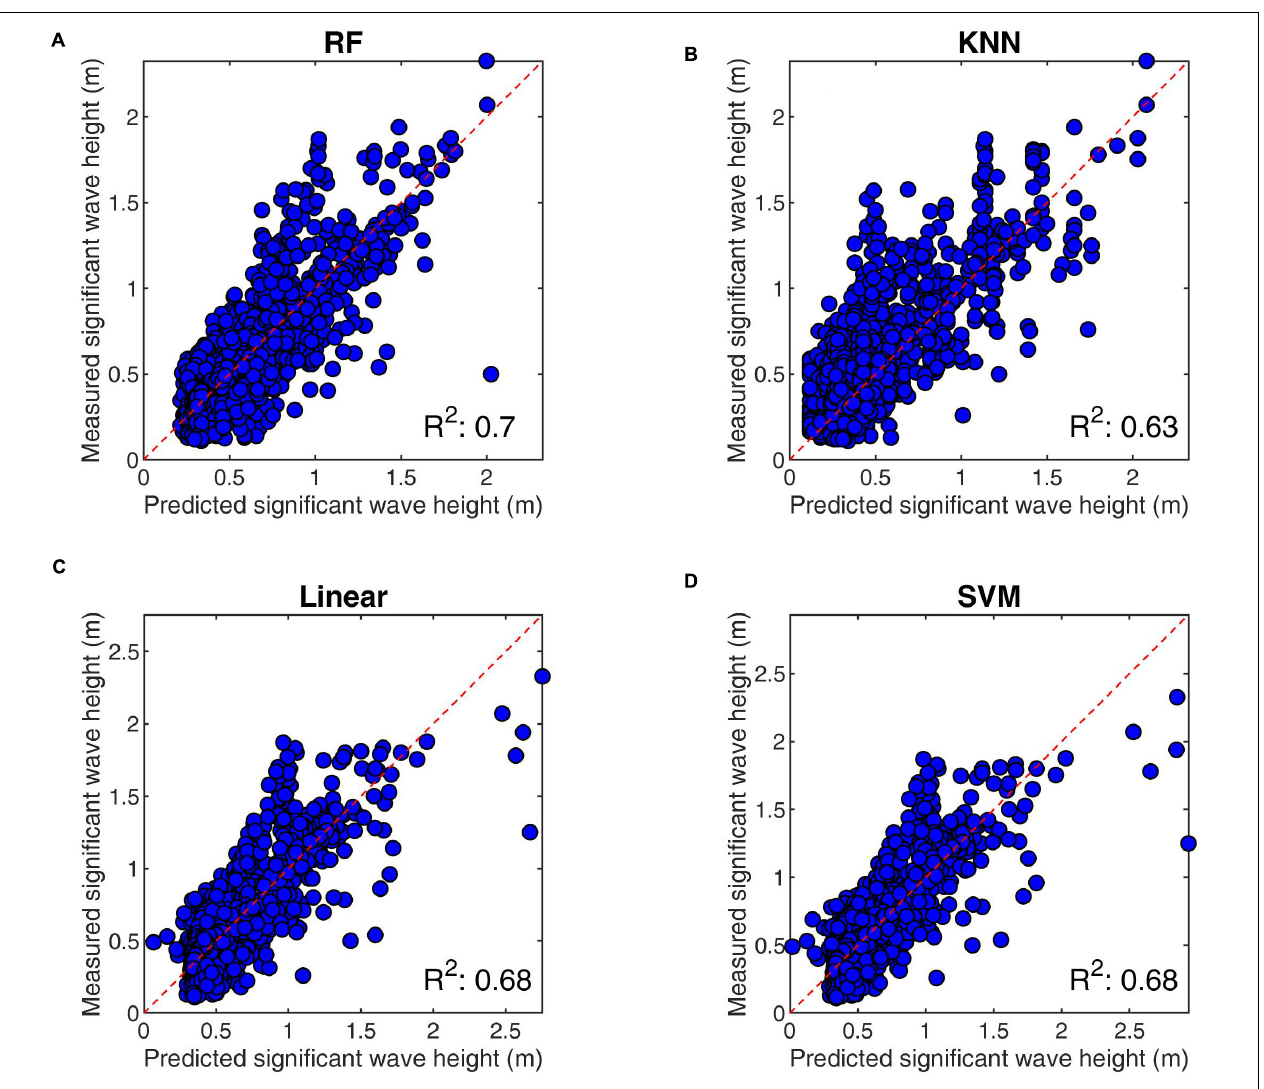
FIGURE 13 | Scatter plots showing the measured versus the predicted significant wave heights of the Catania buoy from 1 September to 31 December 2014. The prediction was carried out by RF regression (A) , KNN regression (B) , linear regression (C) , and SVM regression (D) . The red dashed line in (A–D) is the y = x line. The value of the determination coefficient ( R 2 ) is also reported in the bottom right corner of the